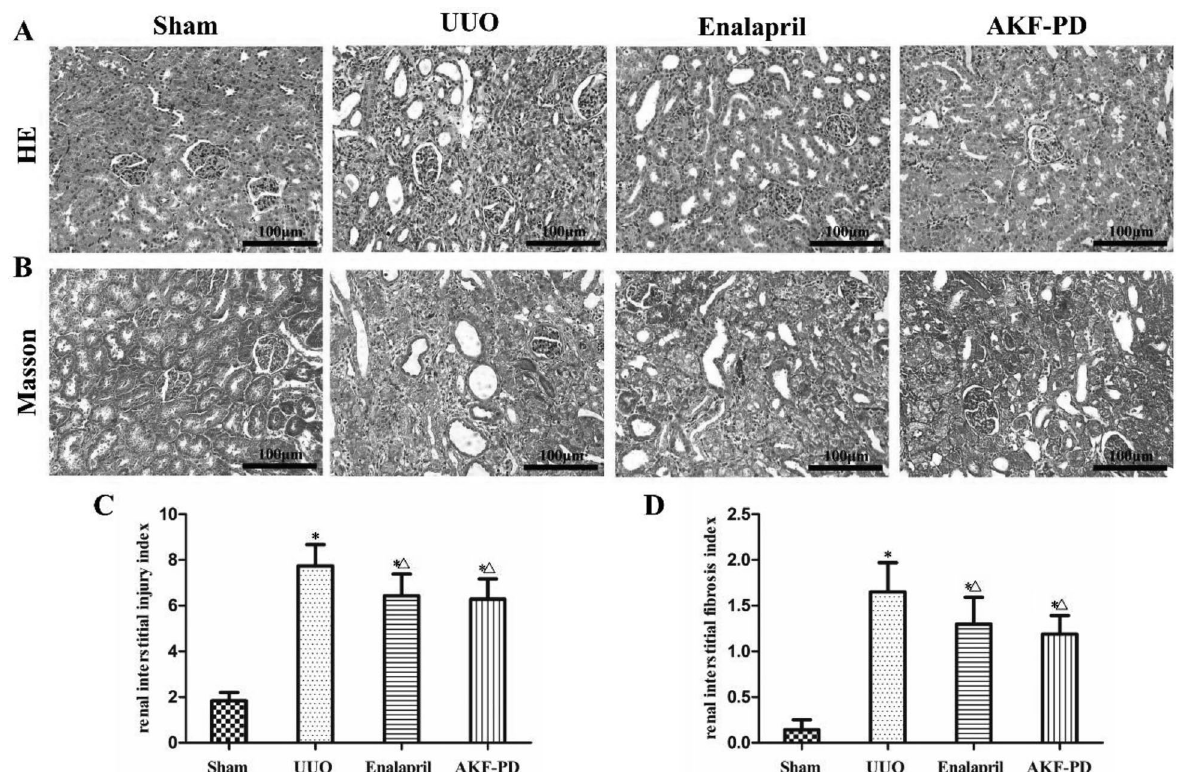
Figure 2. Fluorofenidone (AKF-PD) attenuated renal pathological changes in the unilateral urinary obstruction (UUO) group. A , HE staining and B , Masson staining results in the sham, UUO, UUO + enalapril, and UUO + AKF-PD groups (200 (cid:3) magni fi cation, bar: 100 m m). C , Semiquantitative analysis results of renal interstitial injury index, and D , renal interstitial fi brosis index. Data are reported as means ± SD. *P o 0.05 vs the sham group. W P o 0.05 vs the UUO group